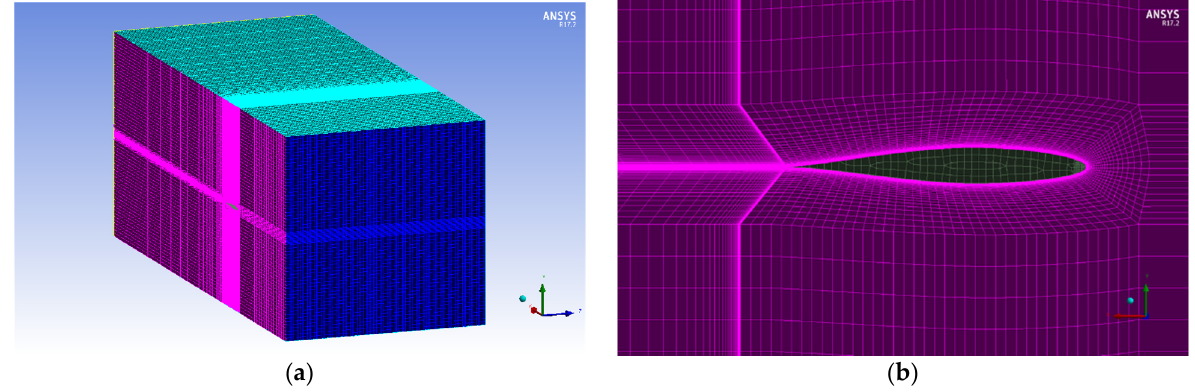
Figure 3. ( a ) Computational domain; ( b ) structured mesh around the wing.